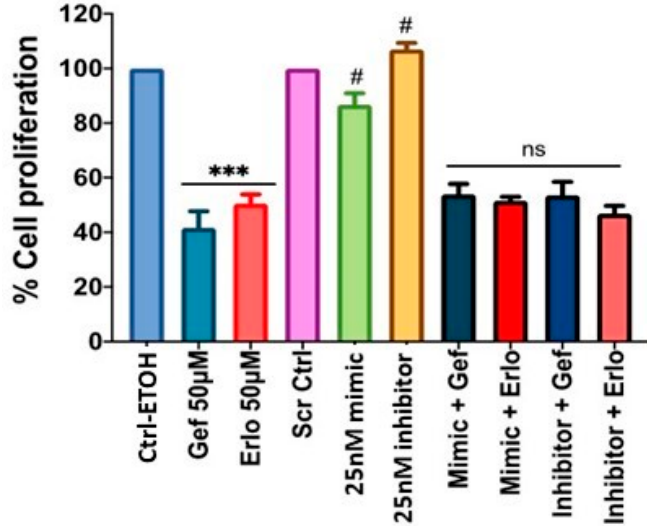
Figure 8. Effect of miR-149-5p mimic and miR-149-5p inhibitor on targeted therapy-induced de- creased cell proliferation. A549 cells were pre-transfected with miR-149-5p mimic or miR-149-5p inhibitor (25 nm, 6 h), followed by treatments with ± Gef or Erlo (50 µM) and vehicle (0.1% ETOH) or scrambled control (25 nM). After 72 h of incubation, the cell proliferation was analyzed via the CV assay. Data are expressed as the mean ± SE of four separate experiments. Statistically significant differences were observed, via one-way ANOVA with the Bonferroni post hoc test, between Ctrl- ETOH and Gef or Erlo (*** = p < 0.001), and, via Student’s t -test, between Scr ctrl vs. mimic (# = p < 0.05) and Scr ctrl vs. inhibitor (# = p < 0.05). “ns” denotes a non-significant change between mimic + Gef, or mimic + Erlo with Gef or Erlo alone treatments, and a similar response was observed with inhibitor + Gef or inhibitor + Erlo.